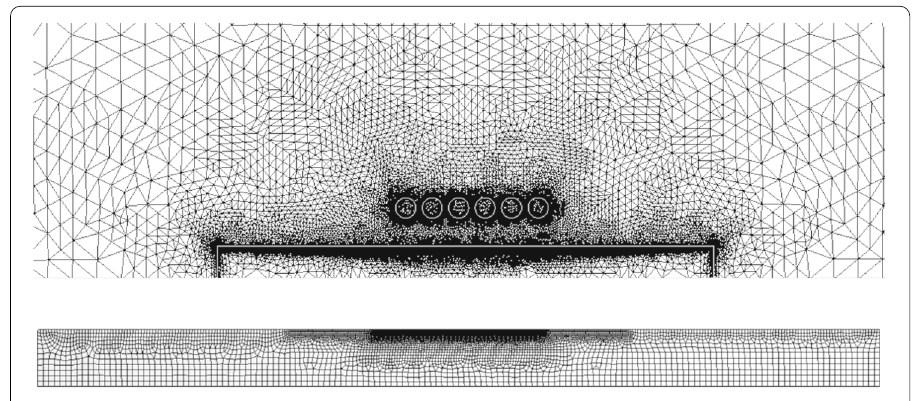
Fig. 8 Mesh of the semi-analytical electromagnetic (above) and thermal (below) analyses